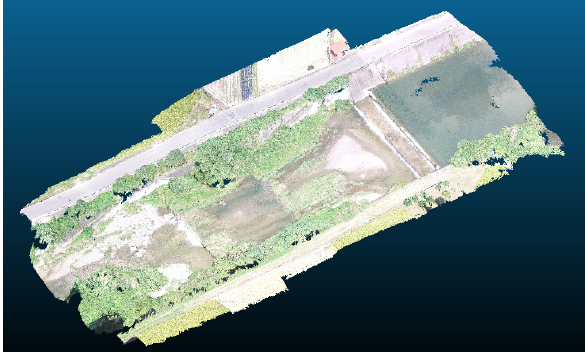
Figure 5. Three-dimensional point cloud data